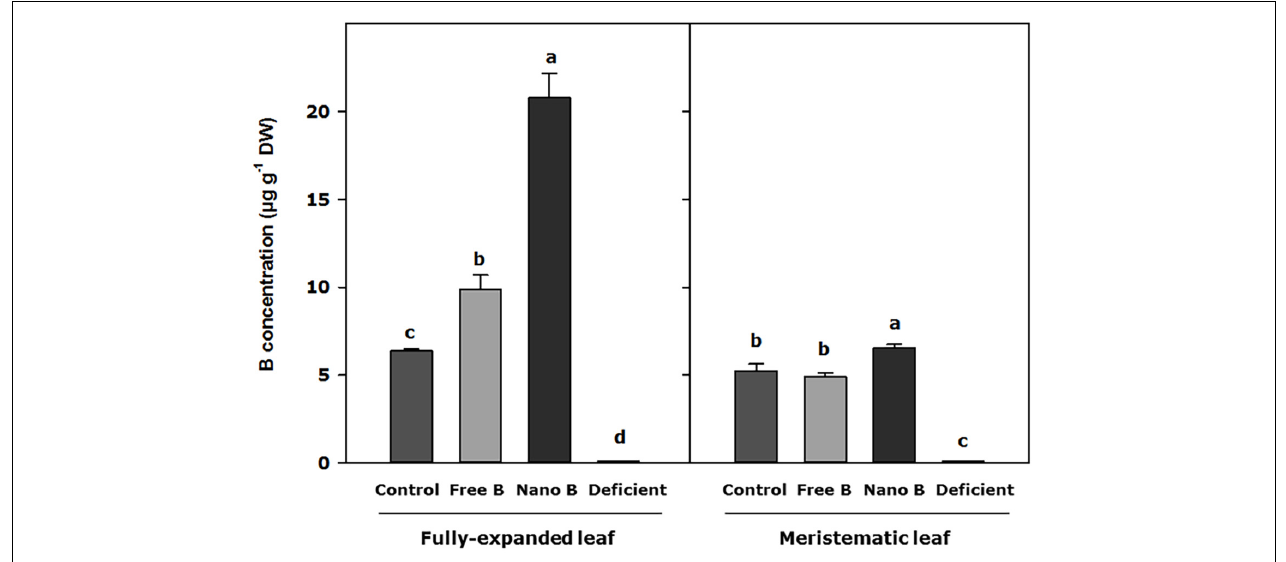
FIGURE 3 | B concentration in the cell wall of almond leaves 7 days after the foliar application of B. B Nano, Nanoencapsulated B. Values are means ± SE ( n = 8). Two independent experiments have been carried out. Columns with different letters differ significantly according to Duncan’s test ( p = 0.05), separately fully expanded leaf and meristematic leaf.